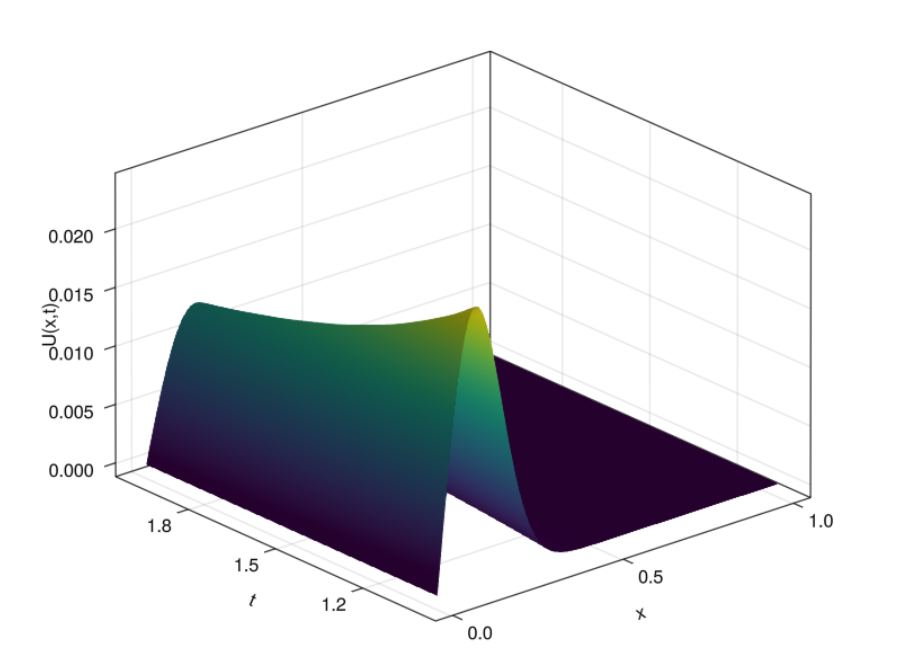
Figure 6. 3D plot of approximated u ( x , t ) .